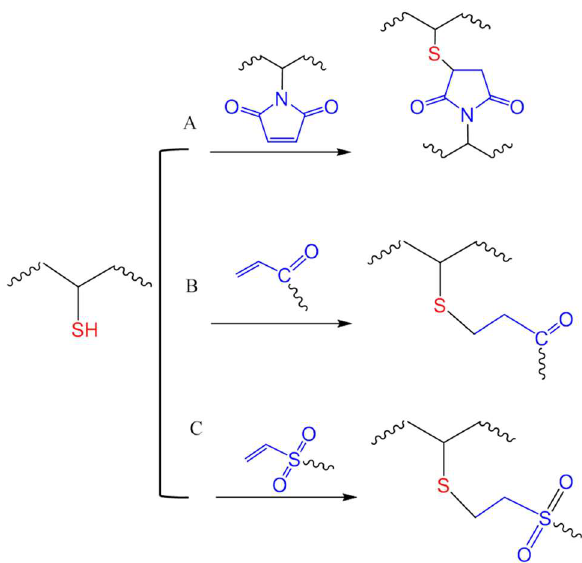
Figure 14. Michael-type additions for in situ crosslinking of polymers through reactions of thiols with maleimide ( A ), acrylate ( B ), or vinyl sulfone ( C ) groups.